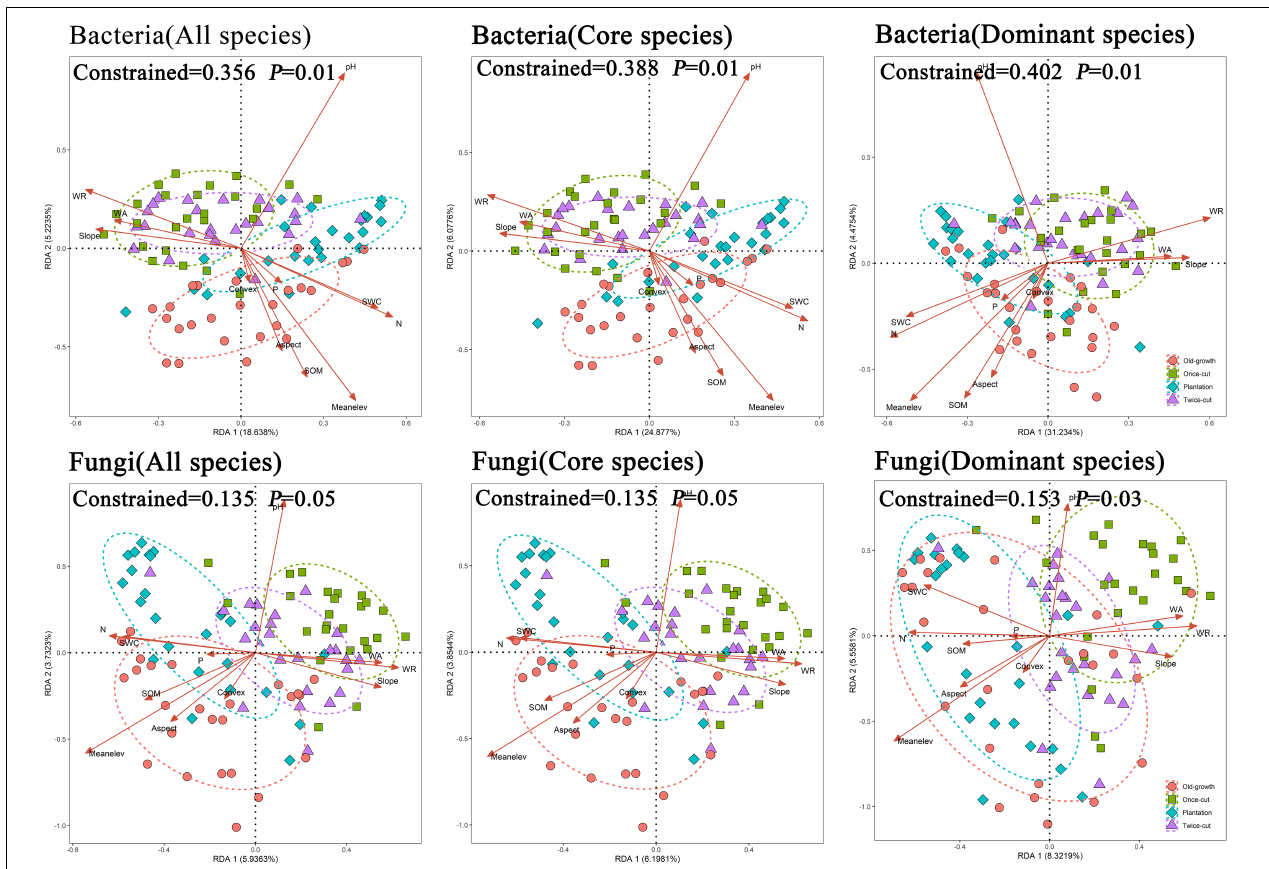
FIGURE 5 | Redundancy analysis (RDA) plot showing the relationship between soil microbes and environmental factors in the experiment. Different colored dots indicate different types of succession. The ellipse has a 95% confidence interval. Environmental factors are indicated by an open-headed red arrow pointing in the direction of increasing values. pH: soil pH, SWC: soil water content, P: soil available phosphorus, SOM: soil organic matter, N: soil alkali-hydrolyzed nitrogen, Meanelev: mean elevation, Convex: convex concave, WA: woody plant abundance, WR: woody plant